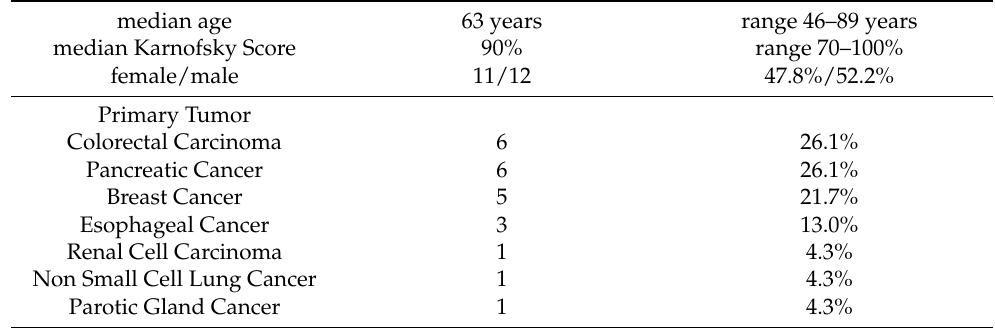
Table 1. Patient characteristics ( n = 23).